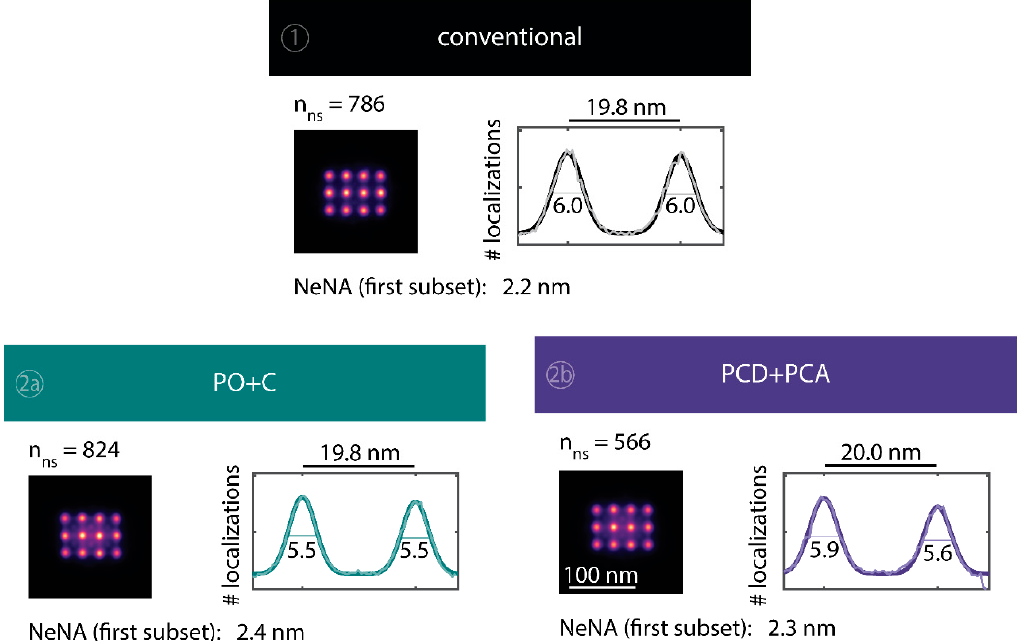
Figure A3. Selected DNA-PAINT super-resolved images of DNA nanostructures showing the depletion of binding sites in the five different conditions. ( a ) Images for the conventional imager (1). Five rows display different nanostructures that showed a high number of initially available docking sites. Images along the five columns represent the localizations within a subset of 5000 frames from a 25,000 frame long measurement. Scale bar: 100 nm. ( b ) Images taken with addition of the oxygen scavenging buffer PO+C (2a), PCD+PCA (2b), extension with an 18-mer spacer (3a) and the combination of 18-mer spacer and PO+C (3b).